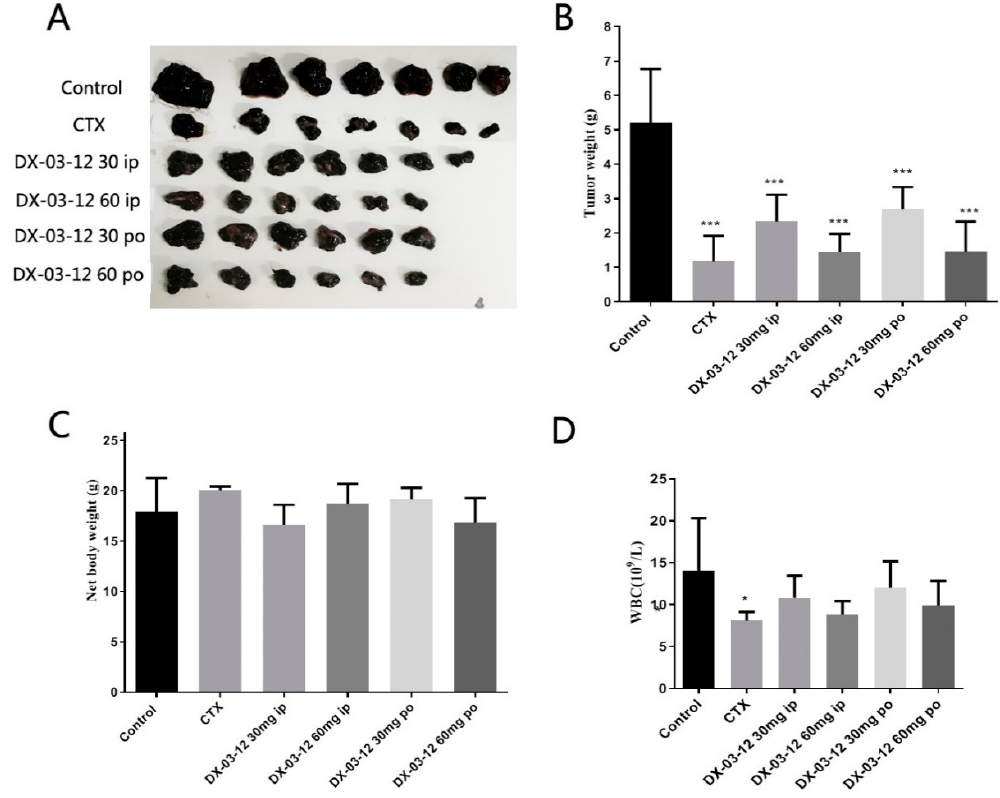
Figure 4. In vivo anti-tumor activity of DX-03-12 in B16F10 xenograft mice. ( A , B ) Tumors from each group after 19 days of treatment. Mice bearing B16F10 xenografts were dosed orally or i.p. with vehicle (0.5% methylcellulose), CTX (Cyclophosphamide, orally, 60 mg / kg twice a week),